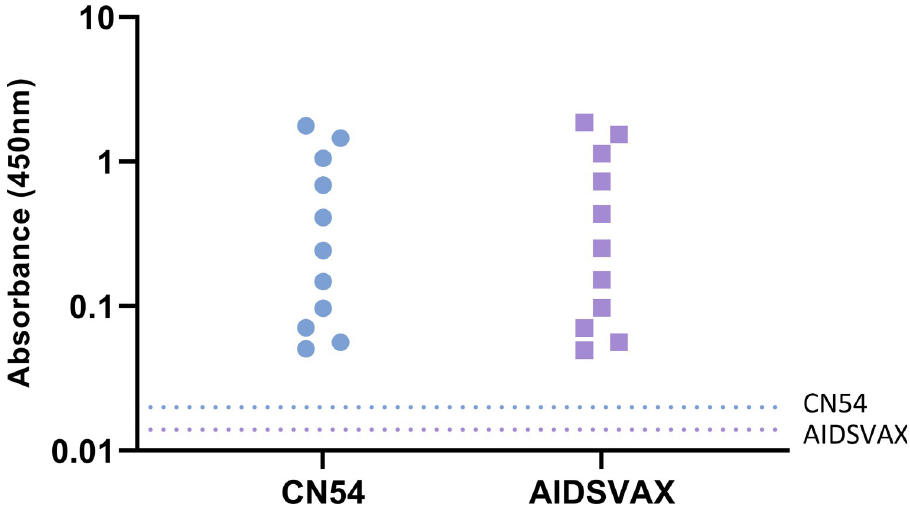
Fig 4. Limit of detection determination. Blue dotted line– 99% CI from Lower asymptote (CN54 ELISA). Purple dotted line– 99% CI from Lower asymptote (AIDSVAX BE ELISA).